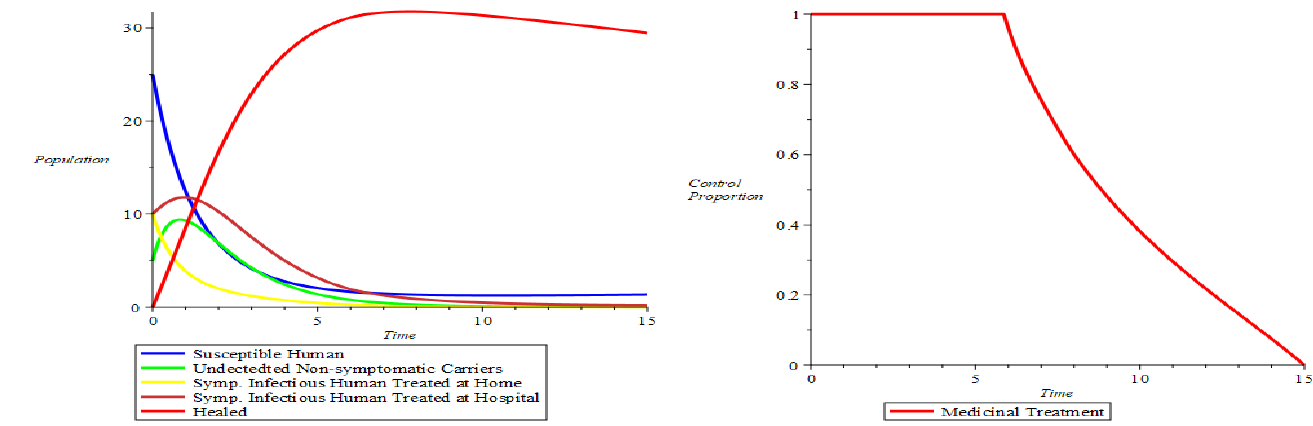
Figure 11. The impact of optimal